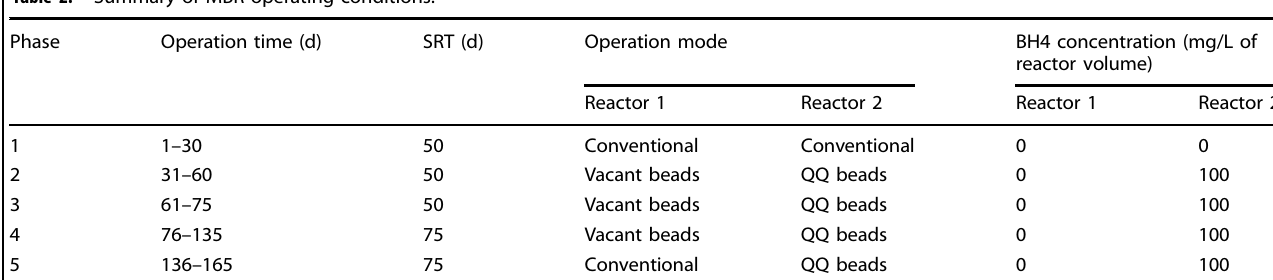
Table 2. Summary of MBR operating